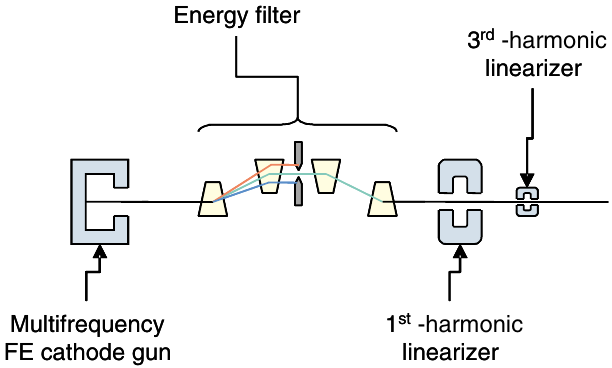
FIG. 13. (Color) Simulated beam line